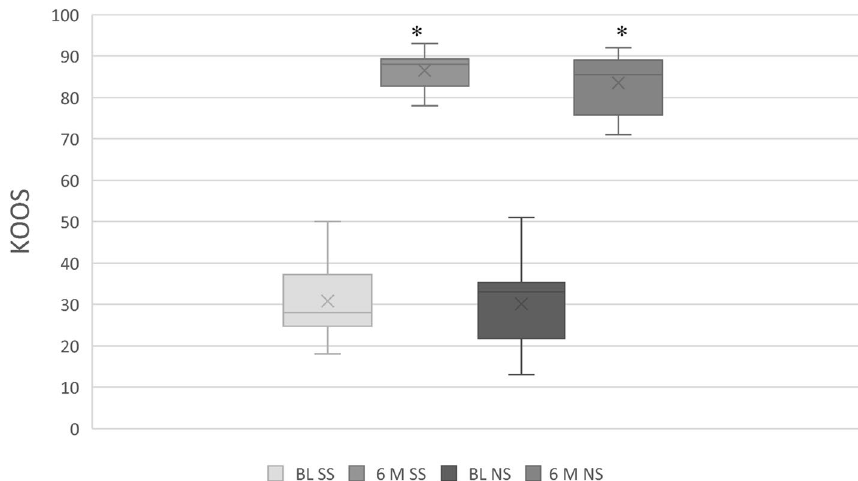
Fig. 1 Box and whisker plot showing Knee Injury and Osteoarthritis Outcome Score (KOOS) total score in patients scheduled for total knee arthroplasty. BL SS, baseline short stature; 6 M SS, postoperative 6 months short stature; BL NS, baseline normal stature; 6 M NS, postoperative 6 months normal stature. The line inside the box signifies the median, the box signifies the interquartile range (IQR), and the whiskers describe the range. * p < 0.05